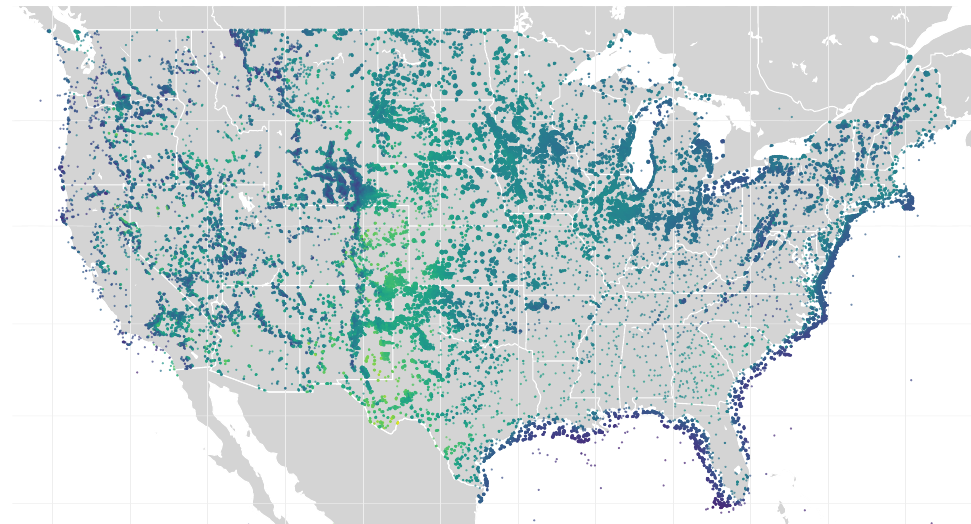
Figure 3. This map shows the 126,692 wind sites on a map of the U.S. The colors indicate the error measures as the sum of R 2 for applying a persistence method 12 h ahead for all the sites. Dark is low error, while lighter color is higher error, a measure that is an indication of the forecast complexity of the